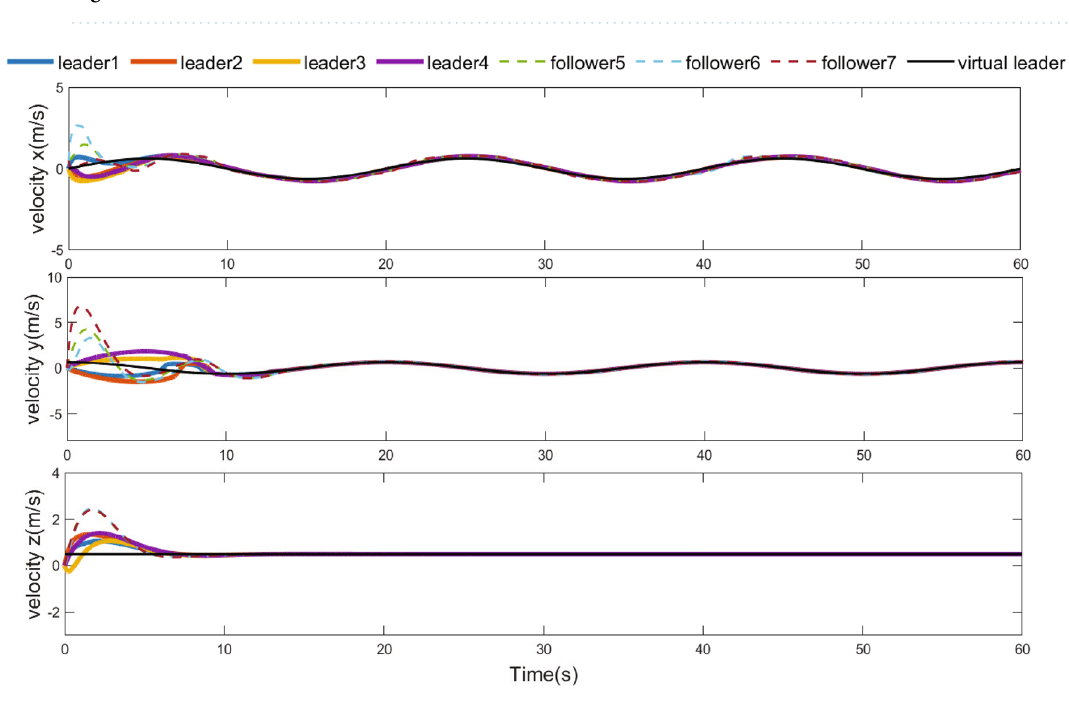
Figure 8. Velocities of